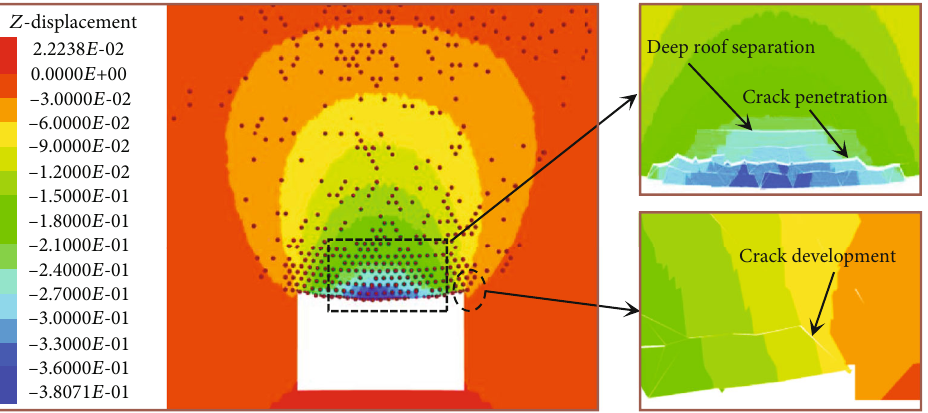
Figure 10: Crack development after roof